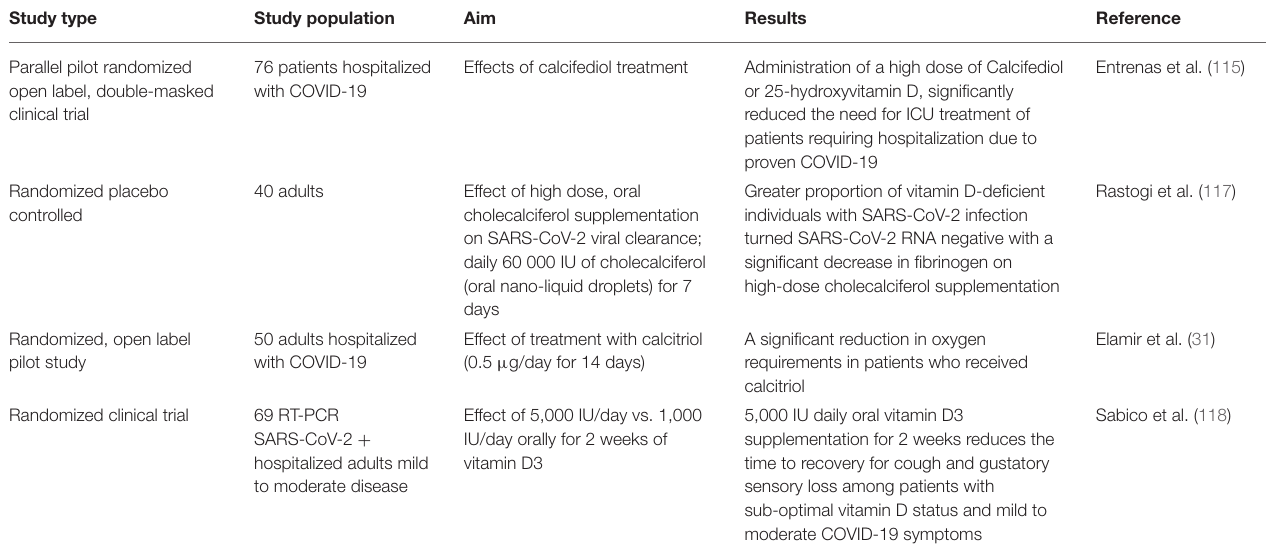
TABLE 3 | Summary of interventional studies of vitamin D supplementation associated with COVID-19 outcomes, studies involving single dose vitamin D supplementation have been excluded. Study